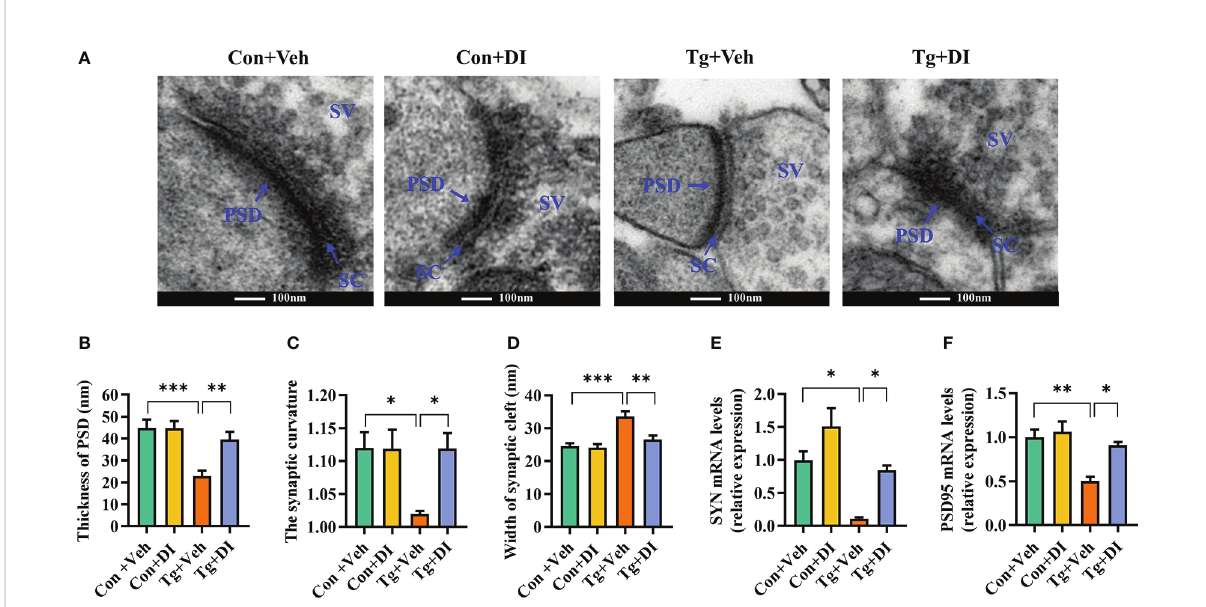
FIGURE 6 Dimethyl itaconate alleviates synaptic impairment in T. gondii infected mice. (A) The ultrastructure of synapses in the hippocampus CA1 region of mice on the electron micrograph (scale bar 100 nm). (B – D) Image analysis of the thickness of postsynaptic density (PSD), the synaptic curvature, and width of the synaptic cleft (SC) ( n = 2, 10 images per mouse). (E, F) The mRNA expression of SYN and PSD95 in the hippocampus ( n = 3). Con+Veh, control mice with vehicle control treatment; Con+DI, control mice with DI treatment; Tg+Veh, T. gondii infected mice with vehicle control treatment; Tg+DI: T. gondii infected mice with DI treatment. Values are mean ± SEM. * P <0.05, ** P <0.01, *** P